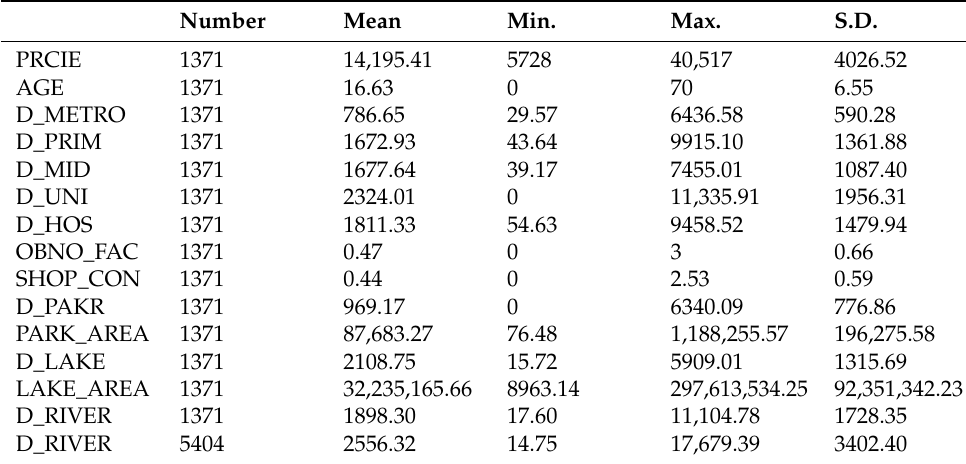
Table A4. Descriptive statistics of data in Kunming.